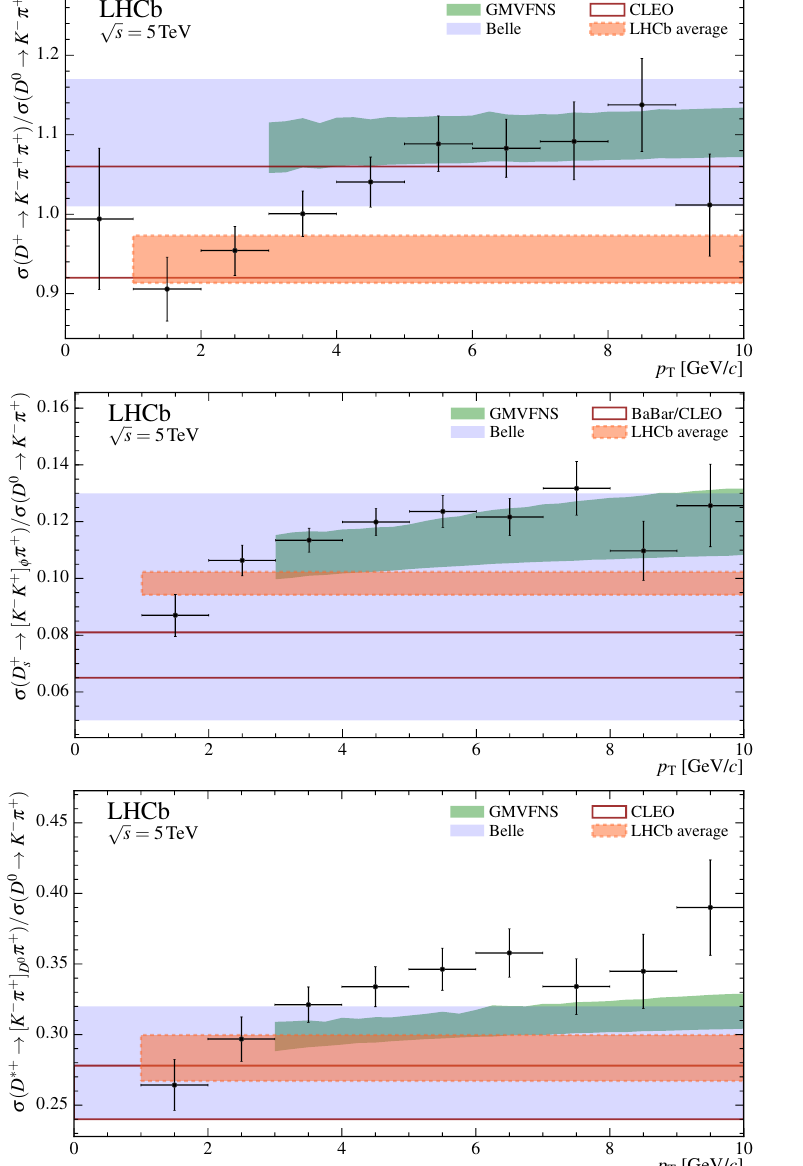
Figure 8. Ratios of the measurements of cross-section times branching fraction of (top) D + , (middle) D + , and (bottom) D (cid:3) + mesons with respect to the D 0 measurements. The bands indicate s the corresponding ratios computed using measurements from e + e (cid:0) collider experiments [41{43]. The ratios are given as a function of p T integrated over y . The notation (cid:27) ( D (cid:27) ( D ) ( D f ). (cid:2) B !